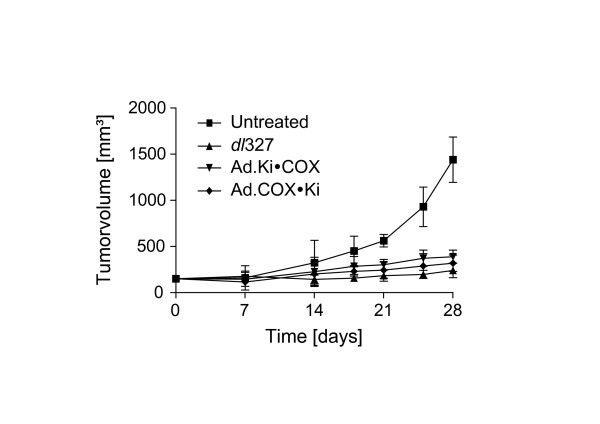
Anti-neoplastic efficacy of adenoviruses. HT-29 xenografts were grown subcutaneously to volumes of ~200 mm3. Groups of mice (n = 8) were treated with indicated adenoviruses by intratumoral injection of 5 × 109 virus particles in 100 μl PBS on day 0 and day 2. Tumors were measured at indicated time points and calculated volumes (mean ± SD) are presented as growth curves.